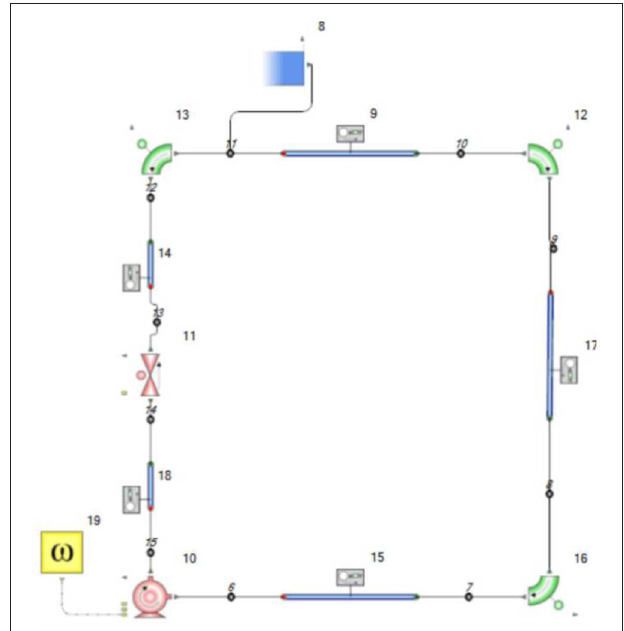
FIGURE 12 | Operation model of multistage centrifugal pump. 8: water tank; 10: centrifugal pump; 11: ball valve; 15, 17, 9, 14, 18: pipeline; 12, 13, 16: elbow; 19: torque controller; others: monitoring nodes.